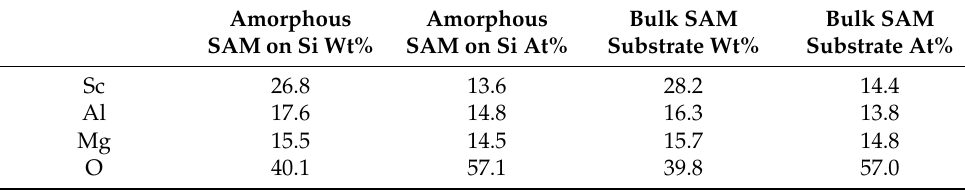
Table 2. Stoichiometry of amorphous SAM film on Si and SAM